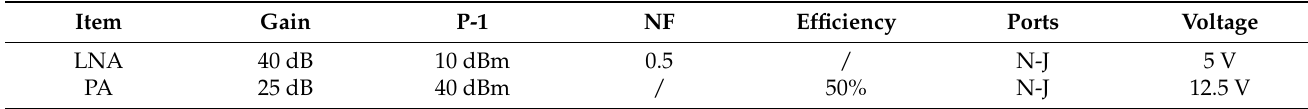
Figure 16. Ground station network antenna design.